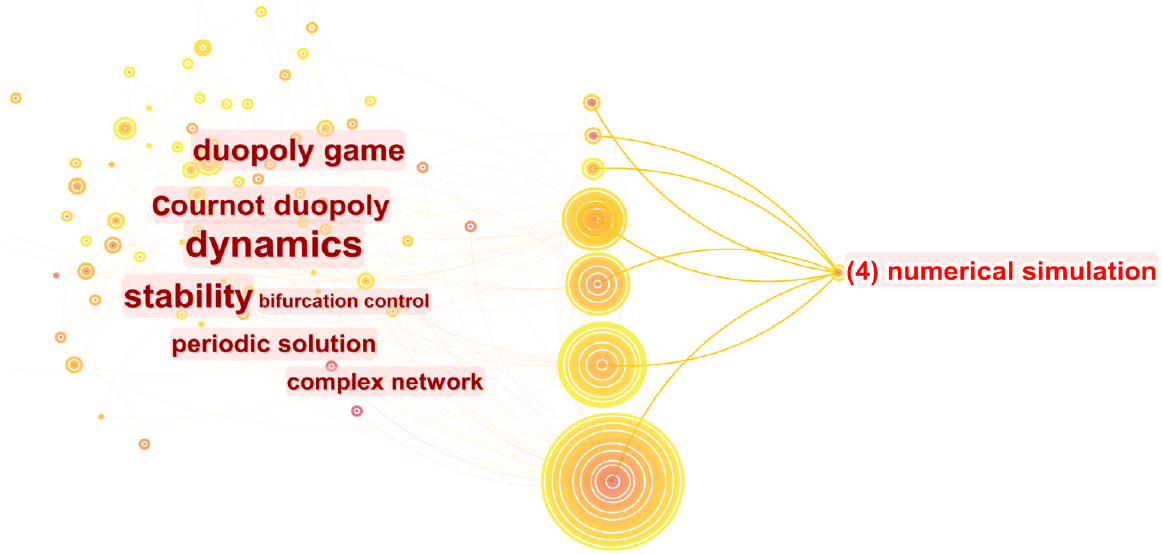
Figure 9. “Numerical simulation” and its co-occurrence key words.